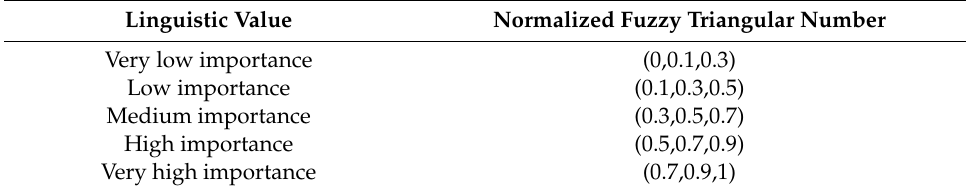
Table 2. Expert linguistic values and corresponding normalized triangular fuzzy